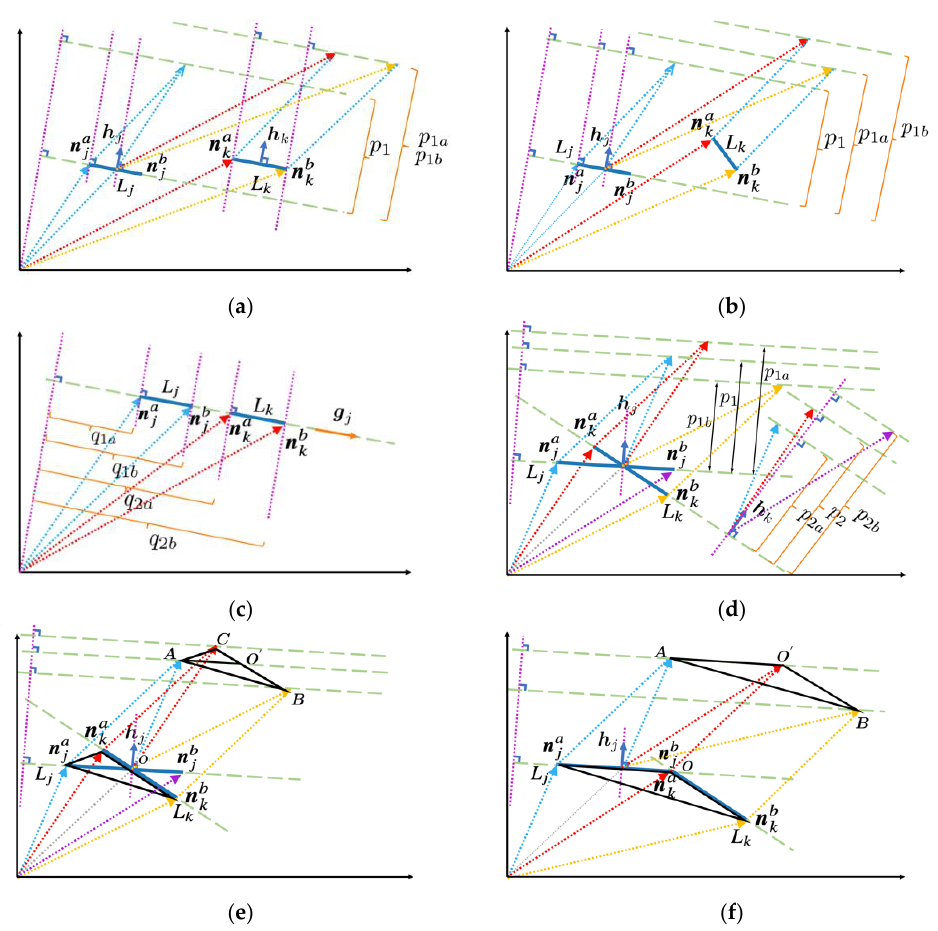
Figure 4. Illustrations of five possible location relationships of two links. ( a ) Case in which the two links are parallel with each other. ( b ) Case in which the two links are not parallel and do not intersect with each other. ( c ) Case in which the two links are collinear but not coincident. ( d ) Case in which the two links intersect but the intersection point does not exist at the endpoints. ( e ) A simplified sketch map of ( d ). ( f ) The two links intersect, but the intersection point exists at endpoints.